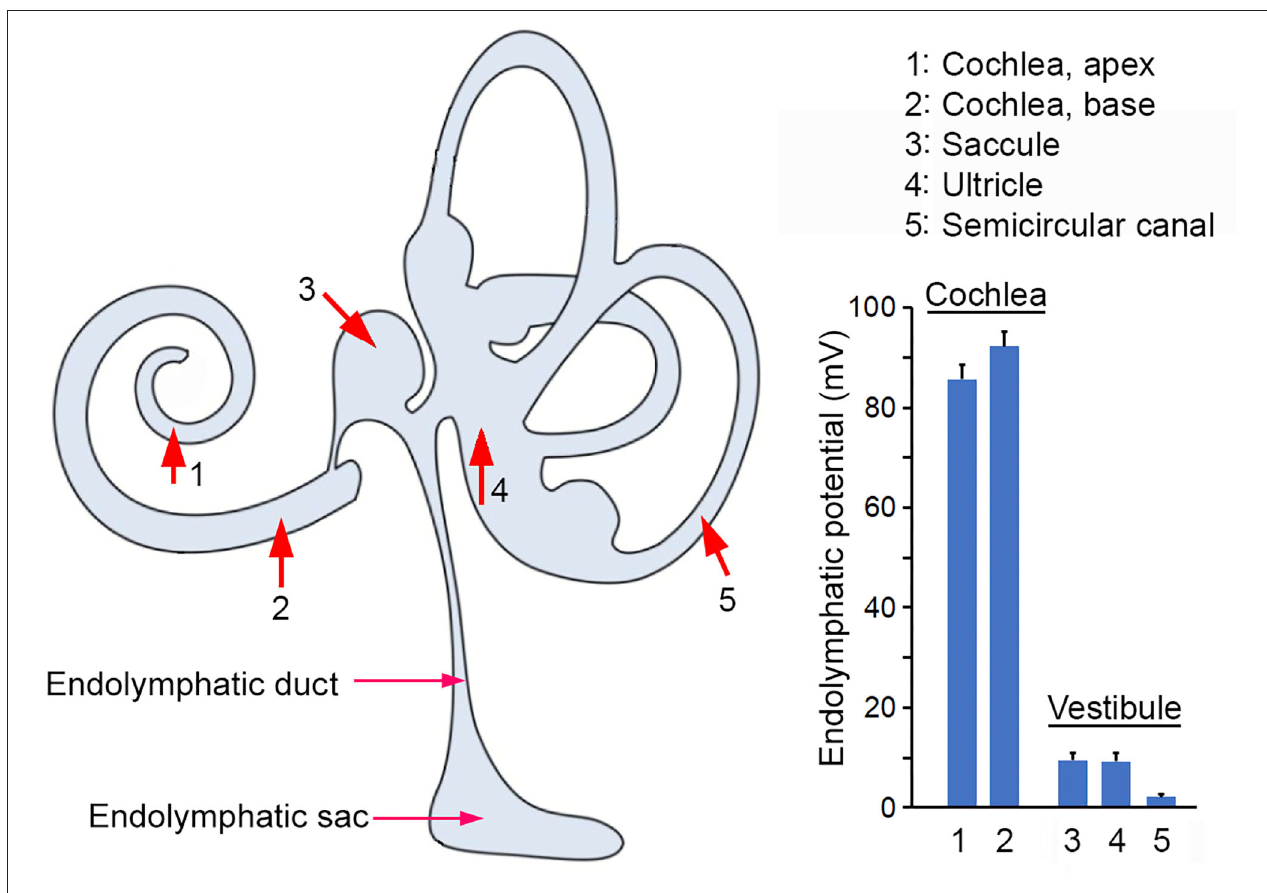
FIGURE 6 | ELP recorded from the inner ear. Red arrows and numerical numbers mark the location where ELP was measured. The magnitude of ELP at different endolymphatic compartments in the inner ear is shown in the right panel. Schematic drawing in the left panel was modified from Kim et al. (2011) with